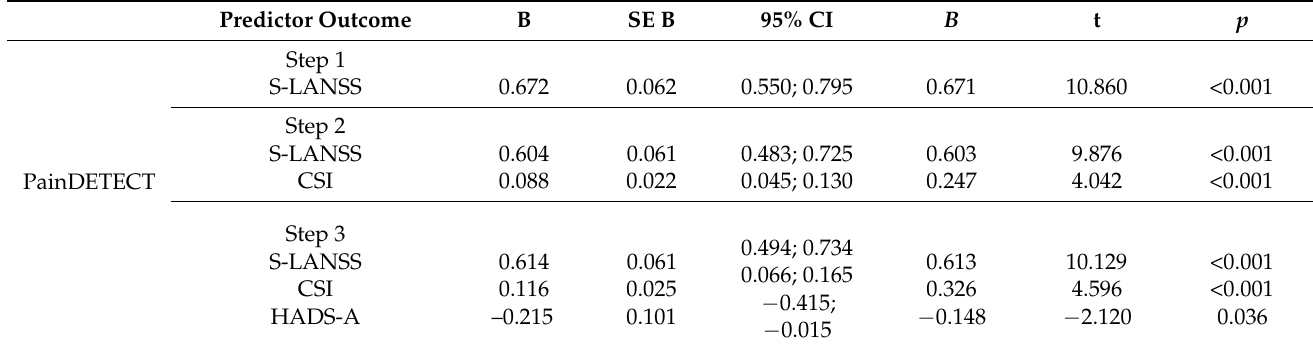
Table 4. Summary of the stepwise regression analyses to determine predictors of